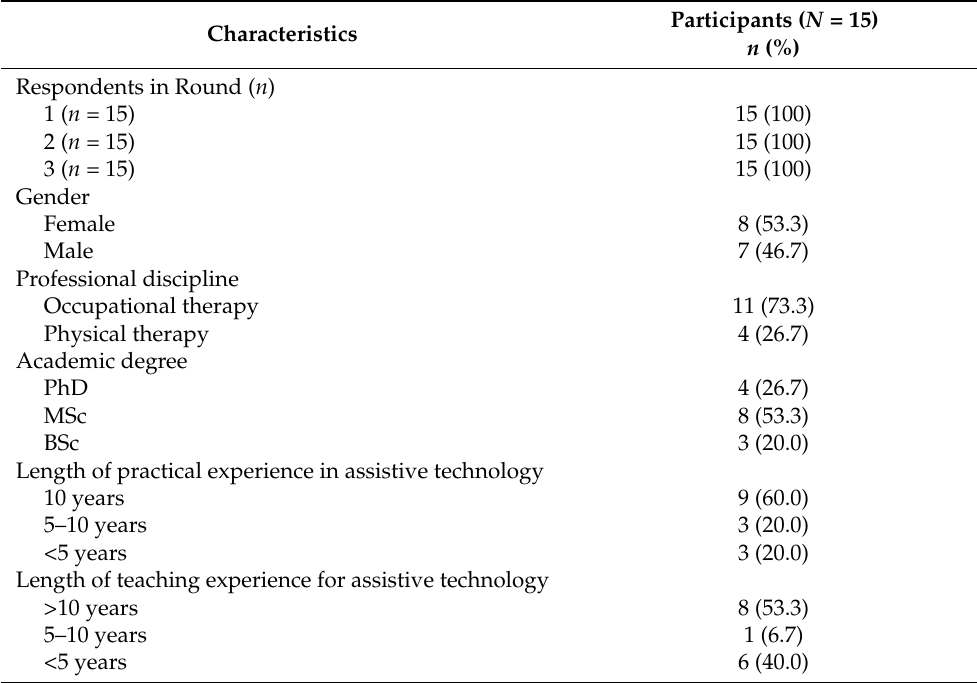
Table 1. Demographic data on the survey participants.